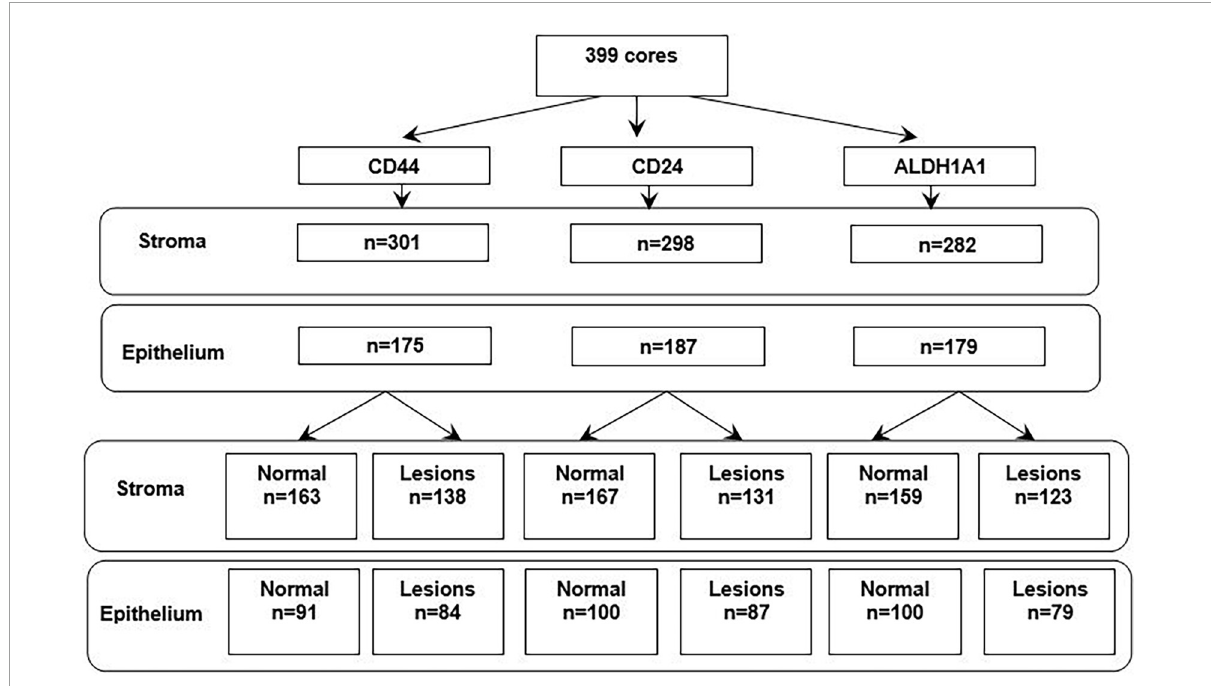
FIGURE3 The number of cores in the study with available readings from pathologist and Definiens, by tissue